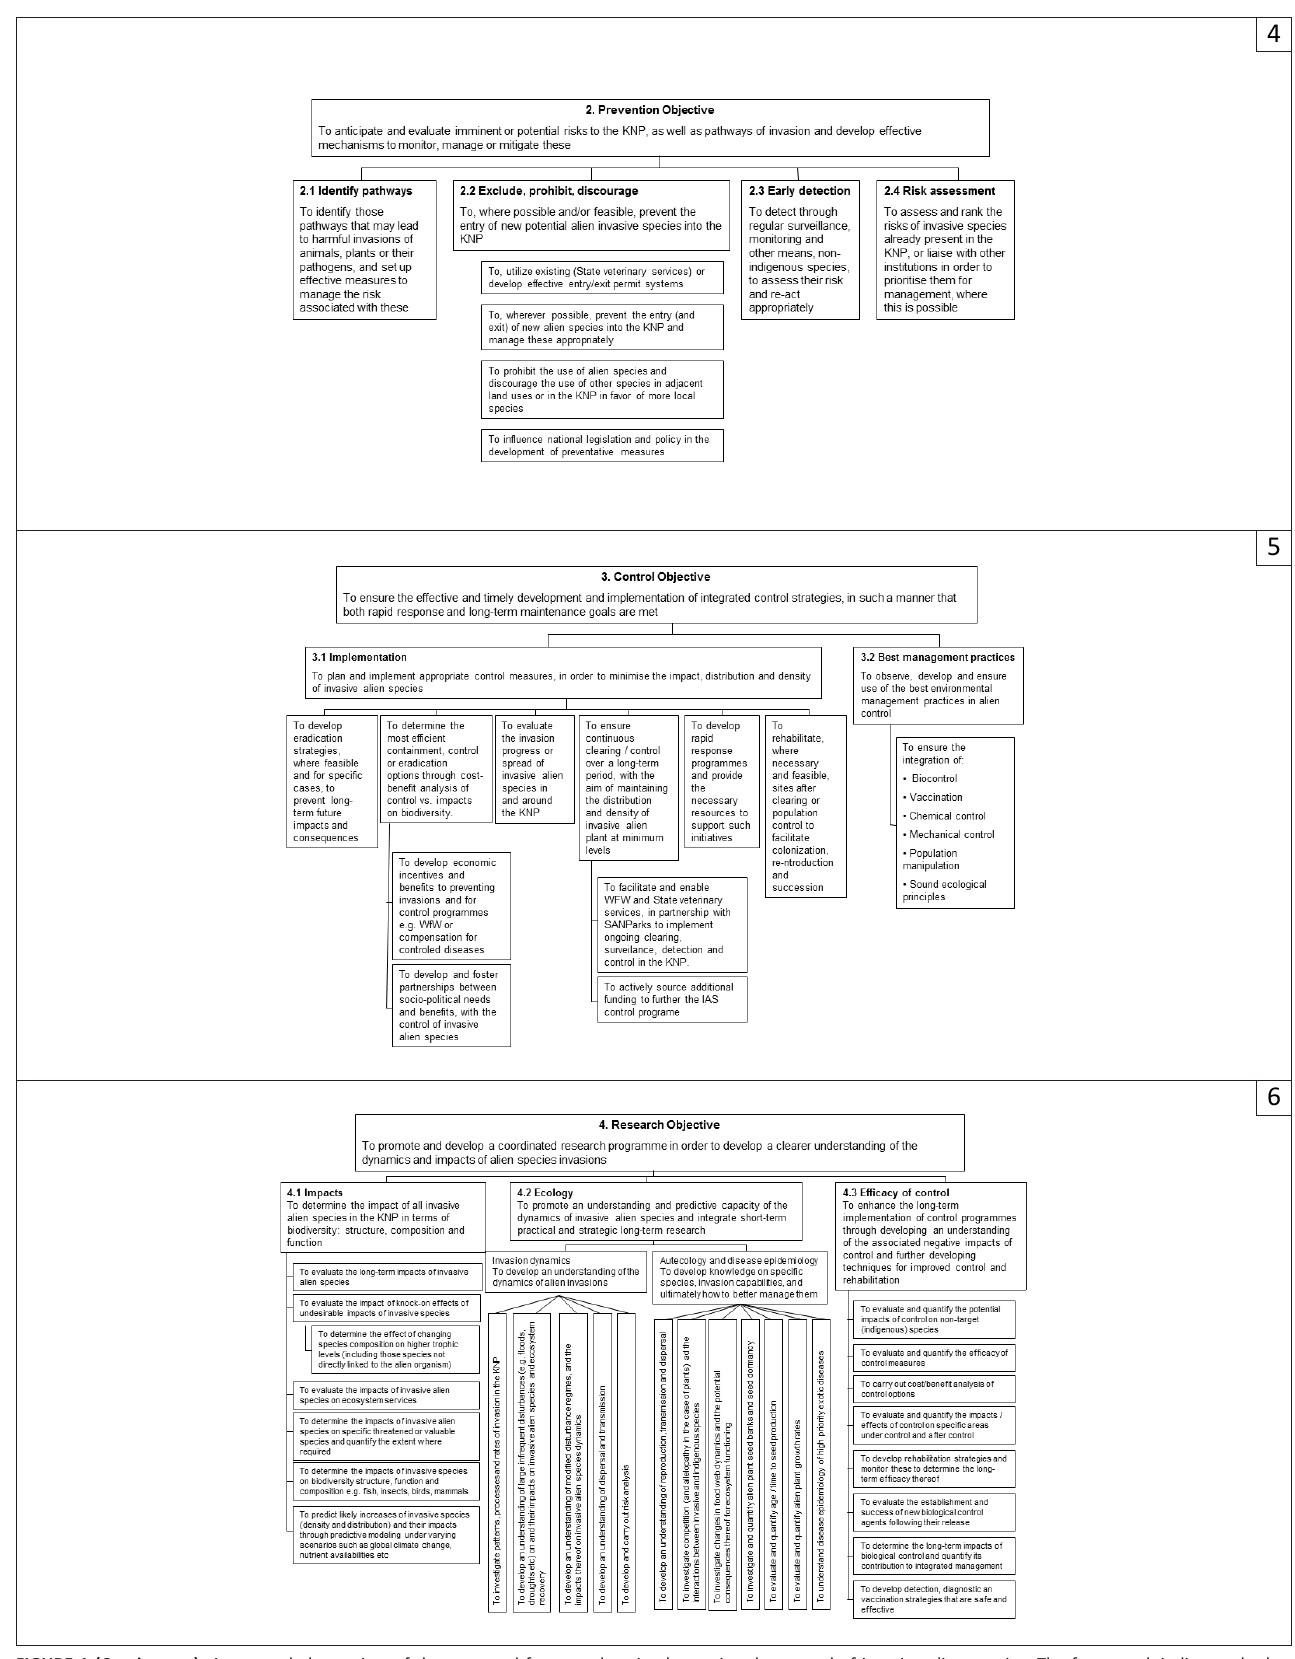
FIGURE 1 (Continues...): An expanded overview of the proposed framework to implementing the control of invasive alien species. The framework indicates the key components, with the salient points, and their linkages. The numbers cross link to the discussion. We also differentiate between documents, activities and/or processes, actions, and bodies and/or